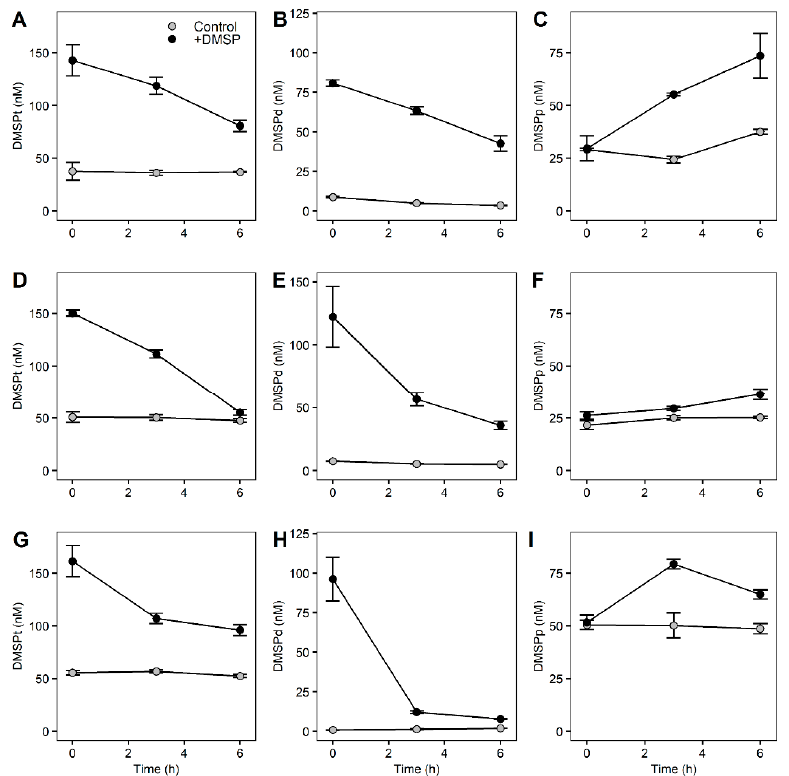
Figure 4. DMSP concentrations of fractionated marine microbial community over 6 h. Top: >8 µ m fractioned samples (DMSPt ( A ), DMSPd ( B ), DMSPp ( C )), middle: 3–8 µ m fractioned samples (DM- SPt ( D ), DMSPd ( E ), DMSPp ( F )), bottom: 0.22–3 µ m fractioned samples (DMSPt ( G ), DMSPd ( H